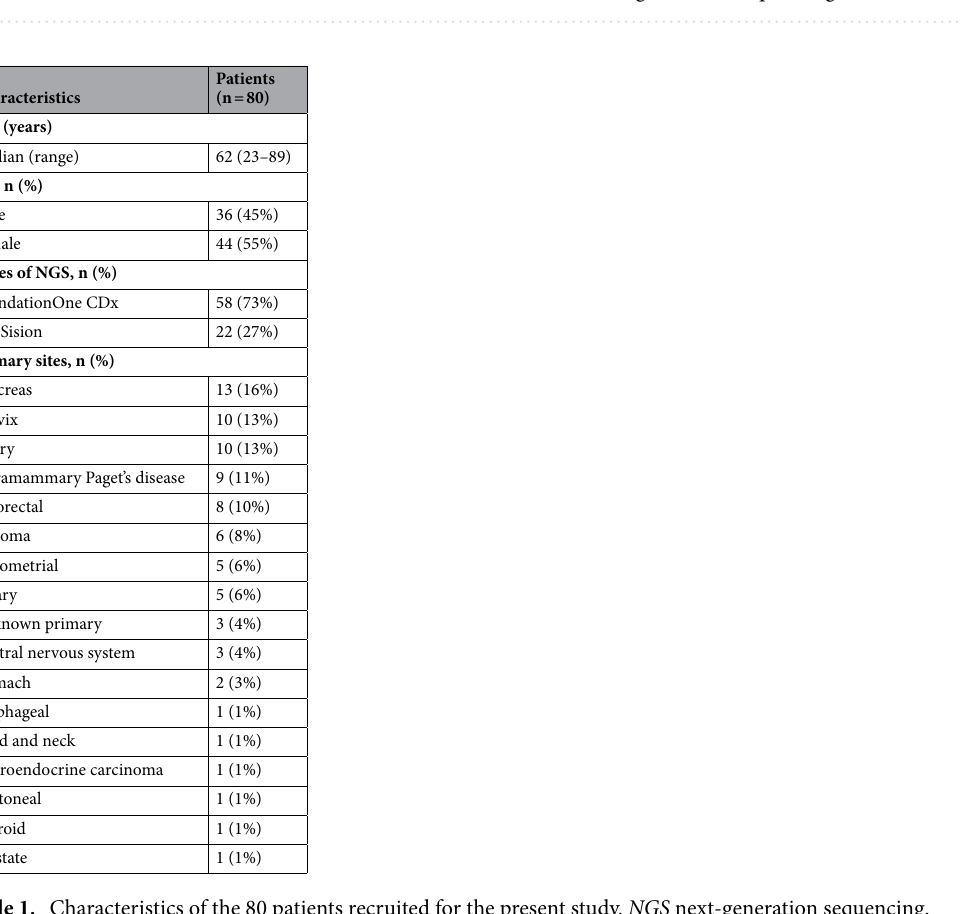
Figure 1. CONSORT diagram of this study. dMMR deficient mismatch repair; MSI-H microsatellite instability high; MSS microsatellite stable; NEC neuroendocrine carcinoma; NGS next-generation sequencing.